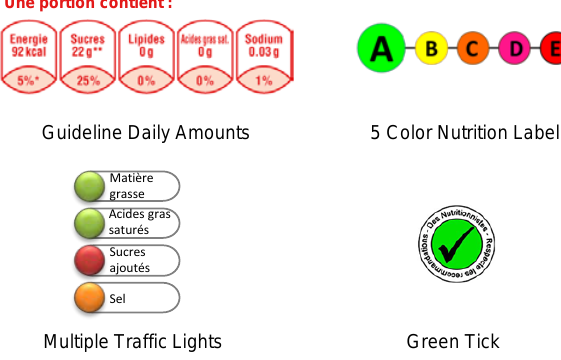
Figure 2. Front-Of-Package nutrition labels used in the study.